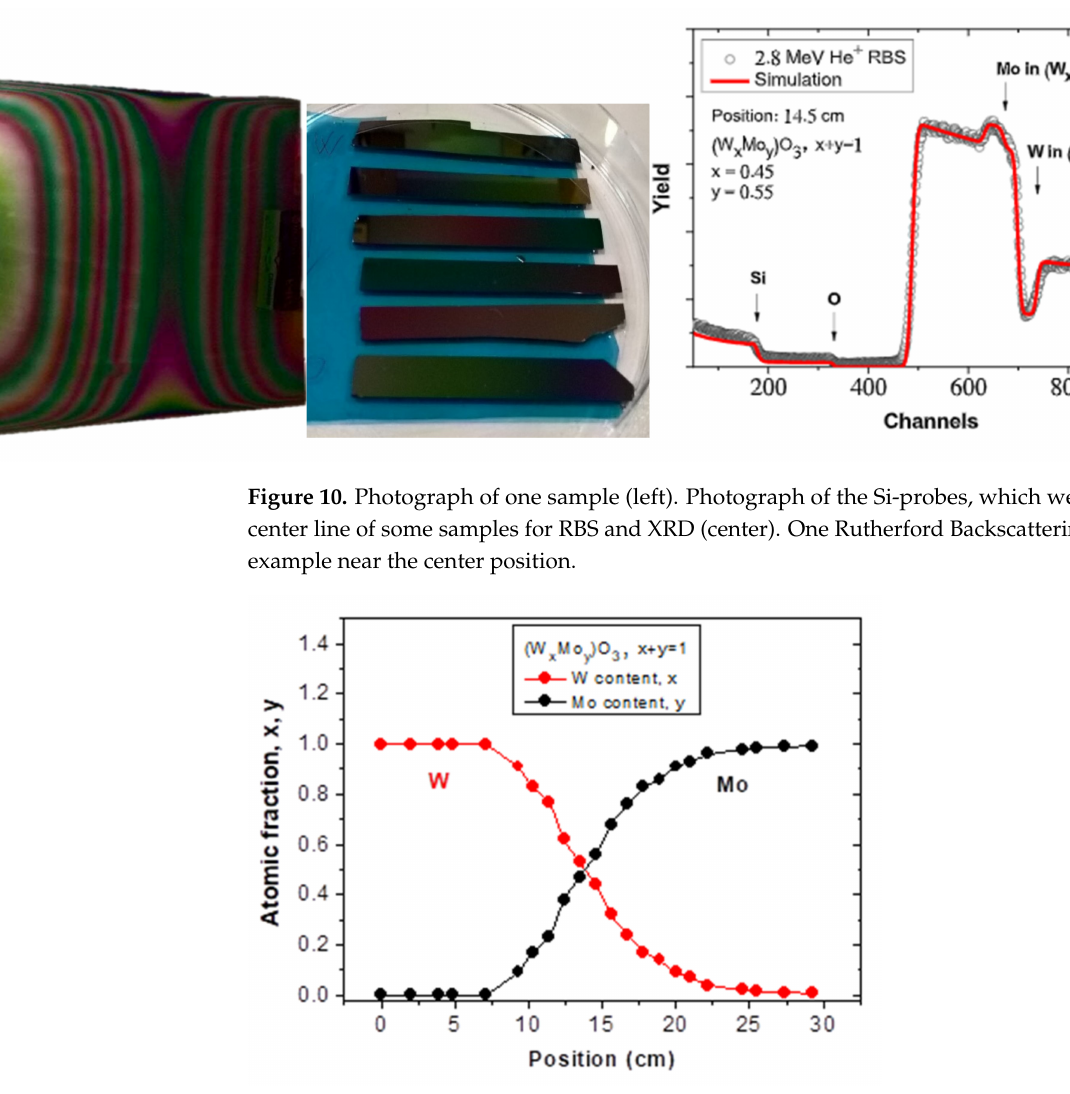
Figure 11. Composition-map along a central line by Rutherford Backscattering